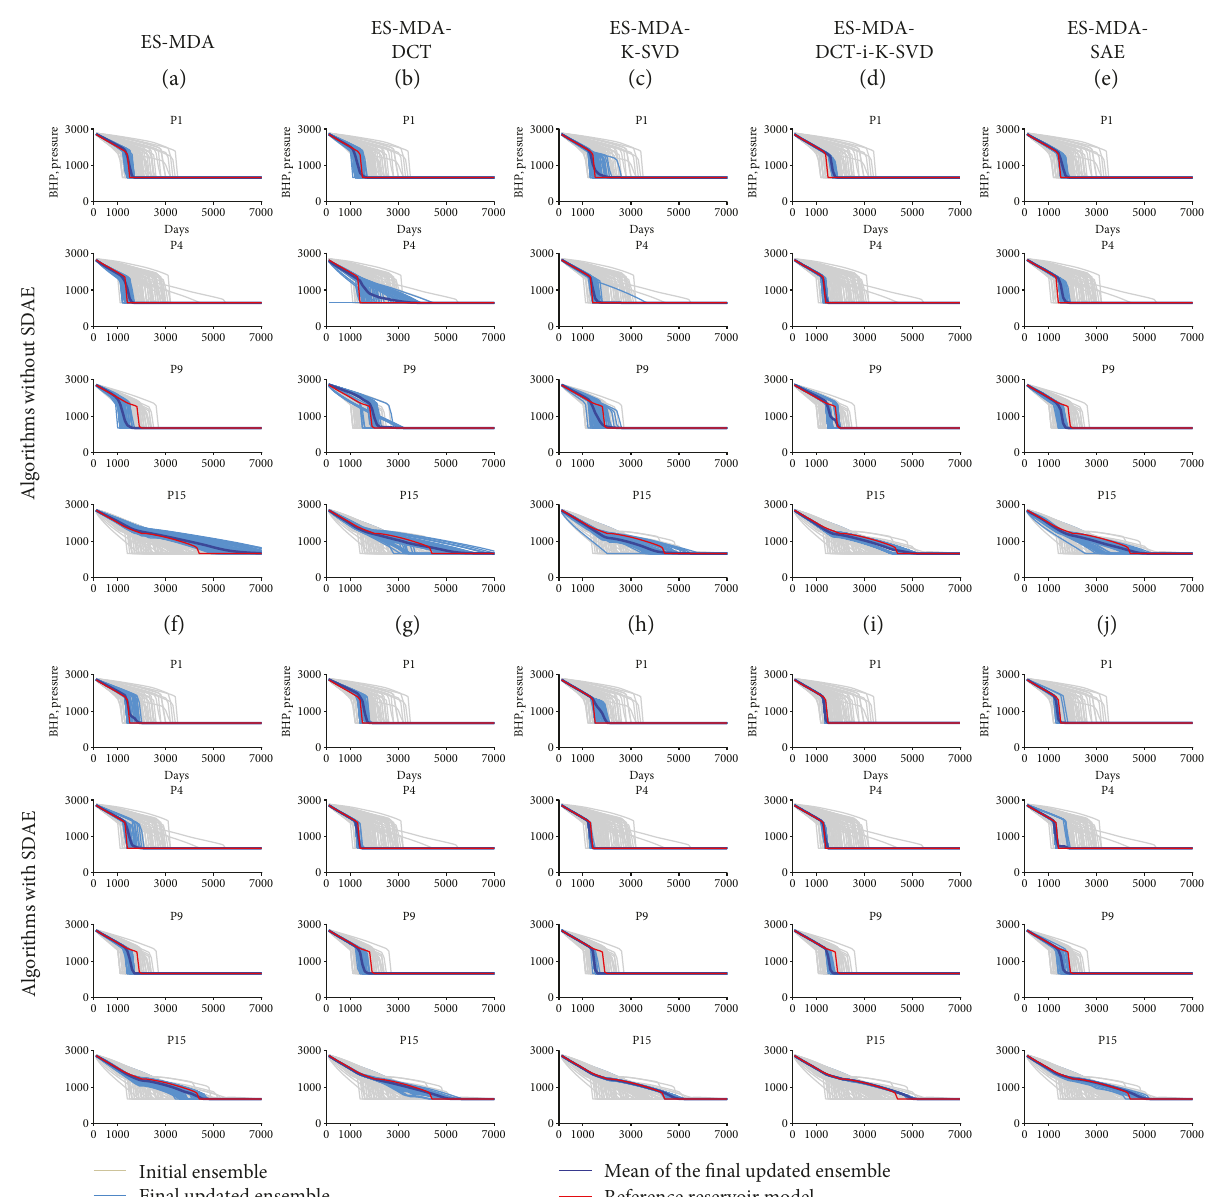
Figure 12: Pro fi les of BHP at the four wells (P1, P4, P9, and P15) obtained by executing the ten ES-MDA algorithms. The latter fi ve algorithms from (f) to (j) are the algorithms coupled with